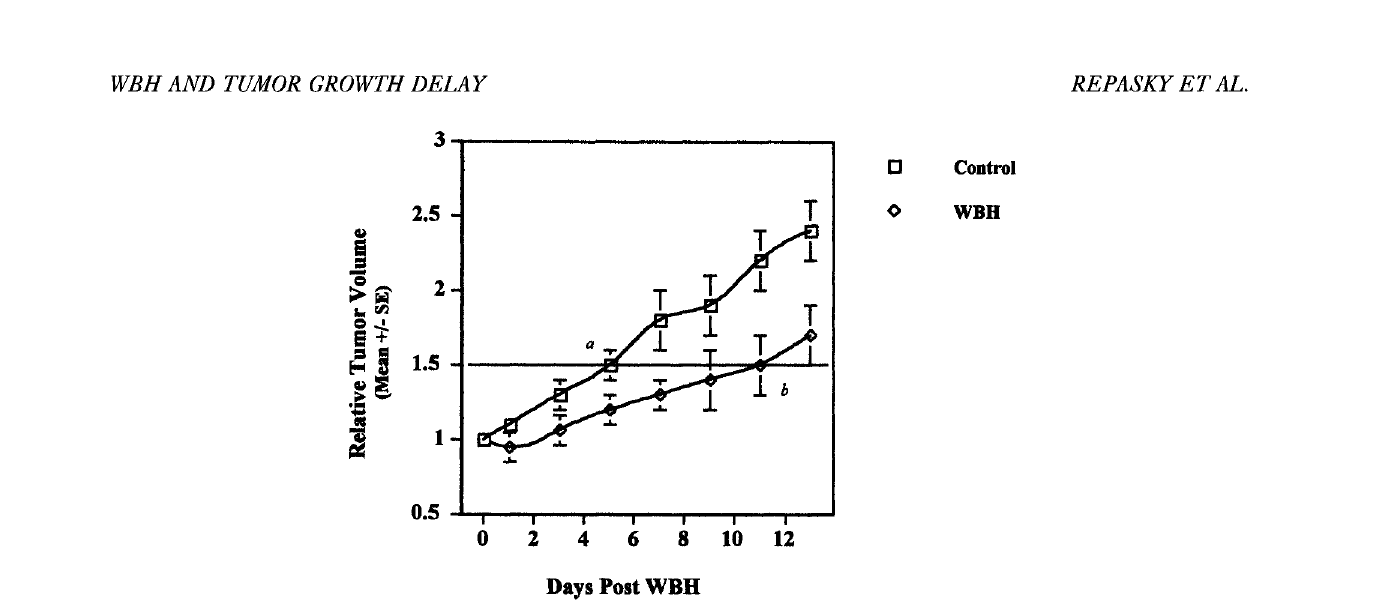
Fig. I. Effect of WBH on the growth of human ovarian tumor #8436. SCID mice bearing a human ovarian tumor were treated with WBH for 6 hours on day 0. Tumors were measured with calipers every other day and relative tumor volume was calculated and graphed vs. days post-WBH (see "Materials and Methods’). In the control group (a; n 5), TGT was